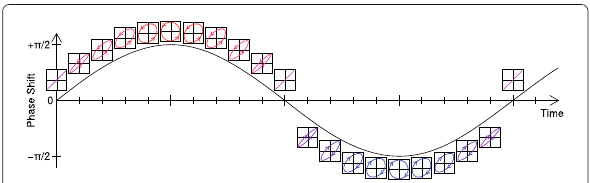
Fig. 22 Schematic representation of the fast polarization switch realized by the SCU